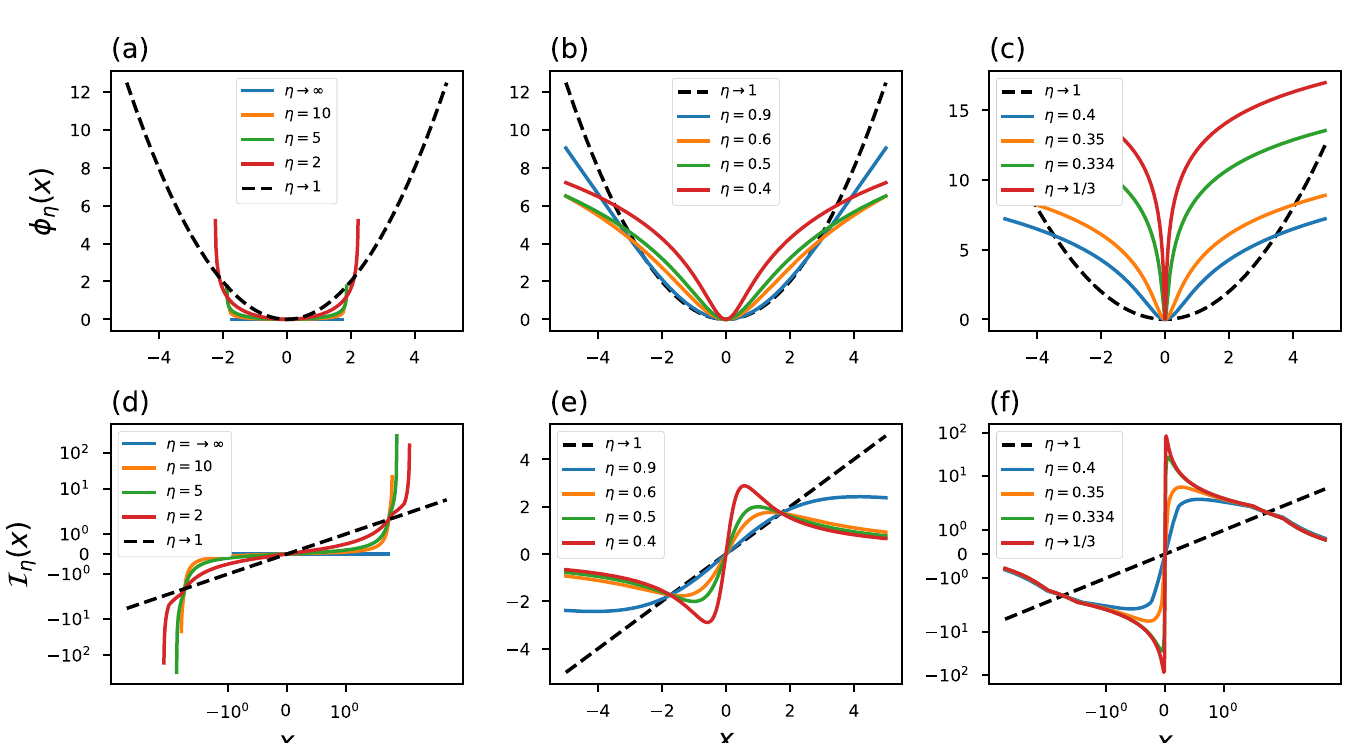
Fig 3. (a)-(c) objective functions and (d)-(f) influence functions generalized based on Re´nyi statistic. The black dashed line represents the conventional curves.